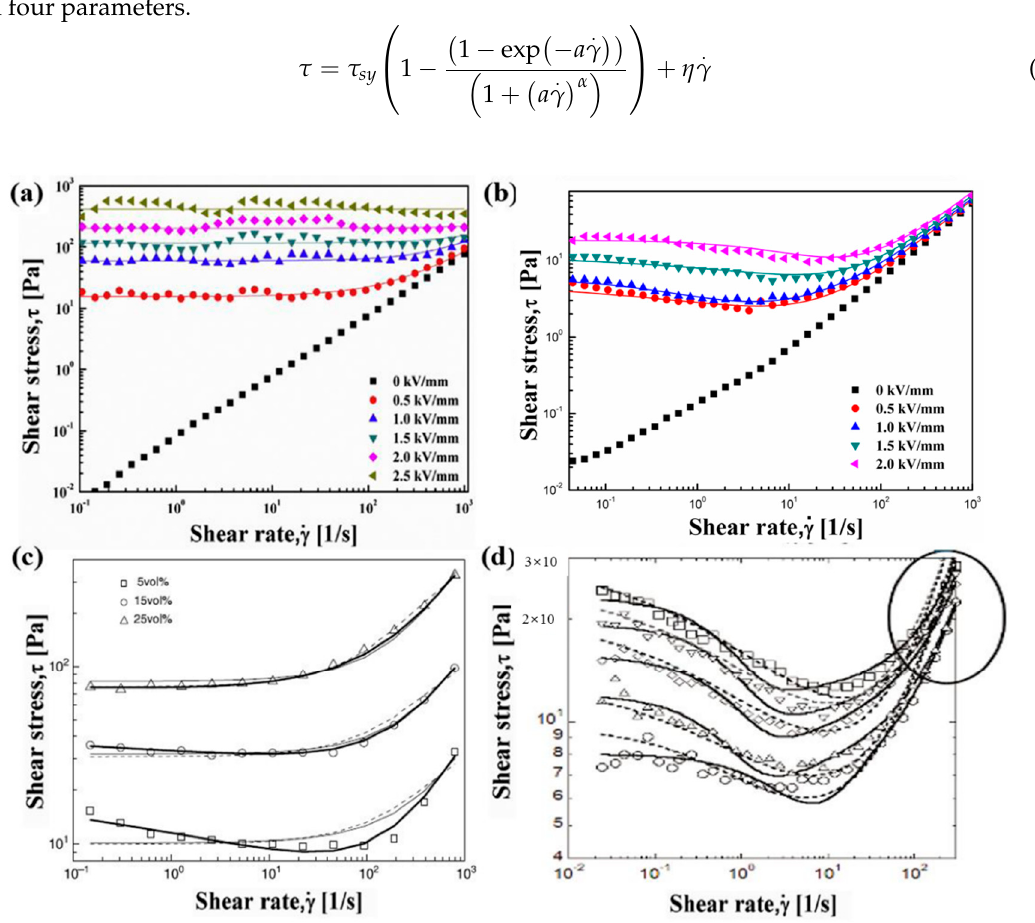
Figure 11. Shear stress vs. shear rate for: ( a ) PS/PANI-based ER suspension (solid lines for Bingham equation), reprinted with permission from [112]. Copyright Elsevier, 2017; ( b ) PANI@ATP-based ER suspension (solid lines for CCJ equation), reprinted with permission from [59]. Copyright Elsevier, 2017; ( c ) poly(naphthalene quinone)-based ER fluid (dashed lines for Bingham equation, solid lines for De Kee-Turcotte equation, and bold solid lines for CCJ equation), reprinted with permission from [84]. Copyright American Chemical Society, 2012; and ( d ) PMMA/PANI-based ER fluid (dotted and solid lines for CCJ equation and four-parameter equation), reprinted with permission from [117]. Copyright Elsevier,